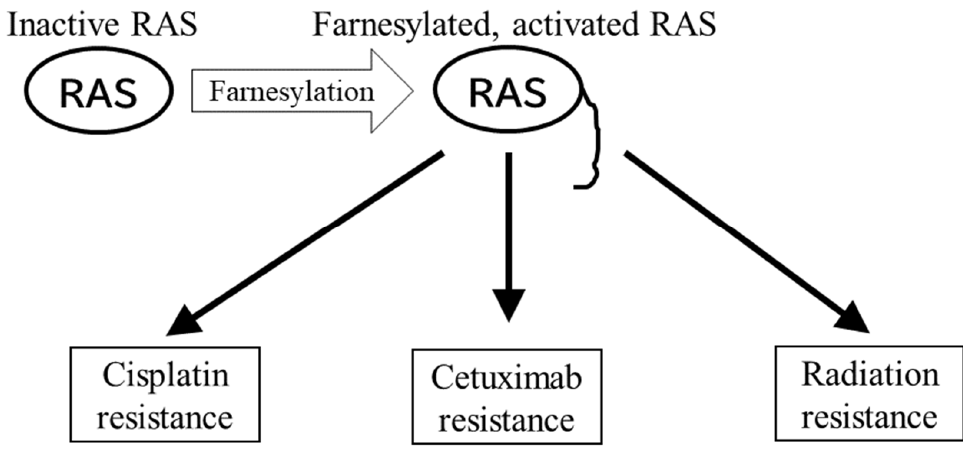
Figure 3. Farnesylation in drug resistance of NPC. RAS is activated through farnesylation. Farnesy- lated RAS promotes drug resistance and radiation resistance.